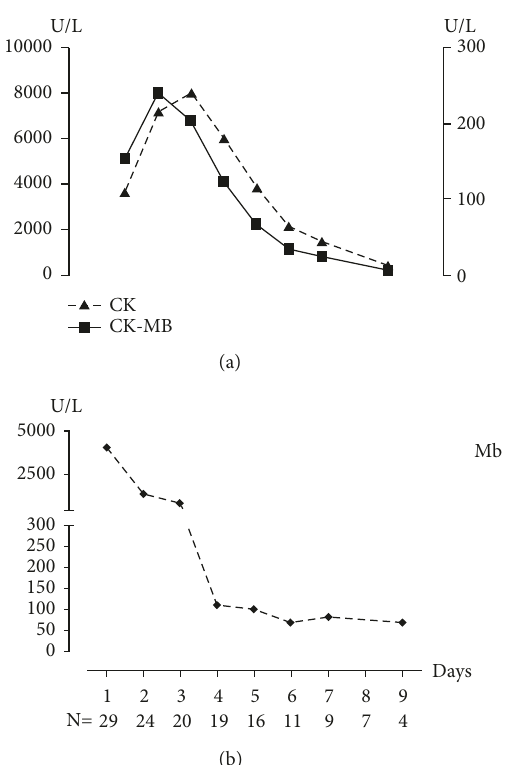
Figure 1: The trend graph of CK, CK-MB, and Mb in cases with rhabdomyolysis. (a) The trend graph of CK and CK-MB during hospitalization. (b) The trend graph of Mb during hospitalization.